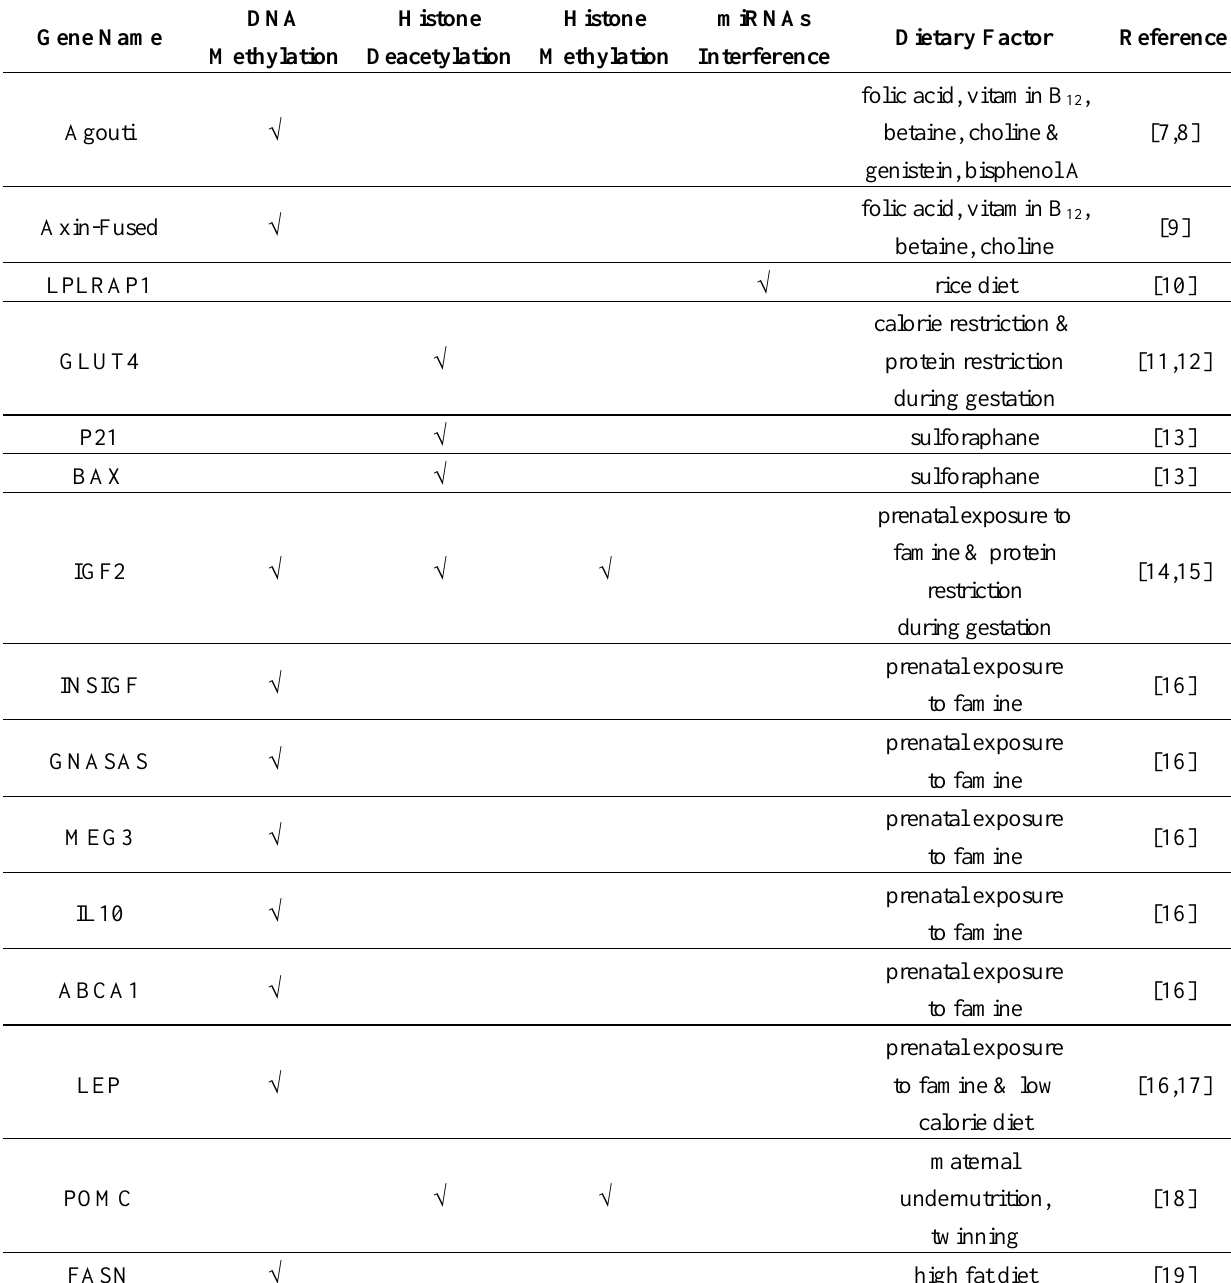
Table 1. An overview of effects of dietary factors on the epigenetic modifications of selected genes. Modified from